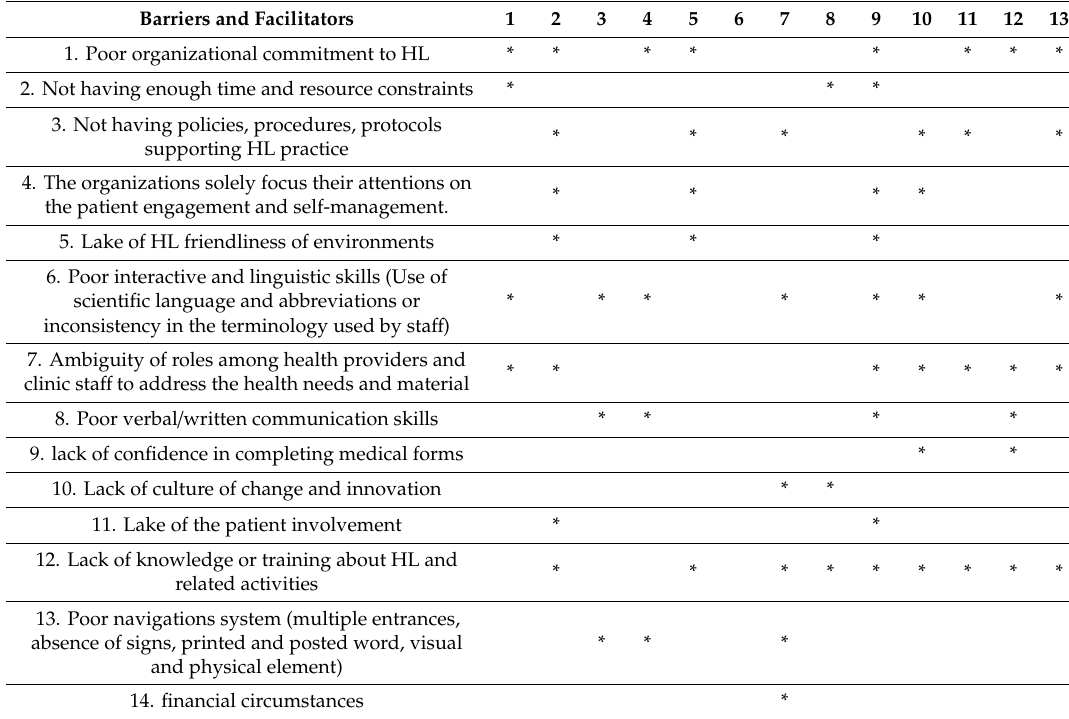
Table 5. Barriers and Facilitators of